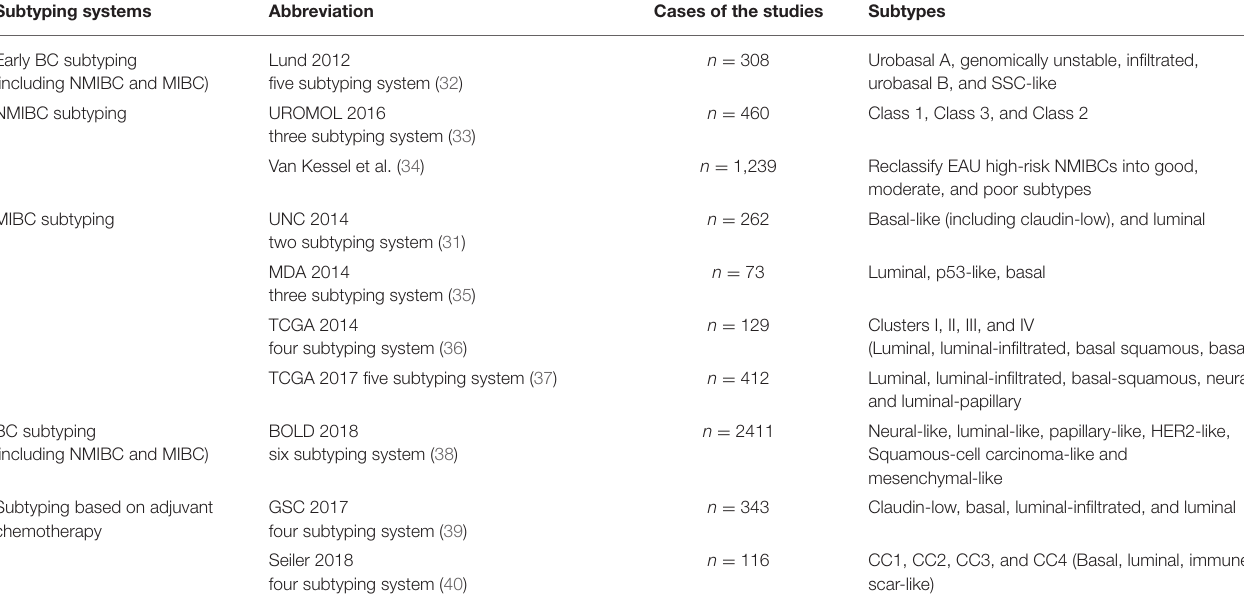
TABLE 1 | Major molecular subtyping